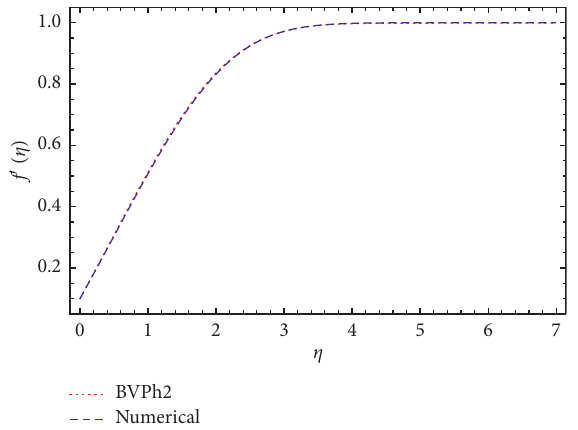
Figure 3: Graphical comparison for two solutions in case of the velocity profile.